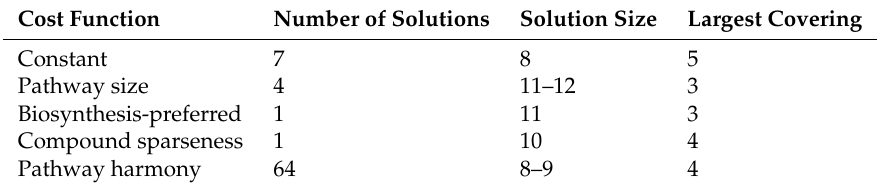
Table 9. Summary of McDonnell 2013 Coverings by